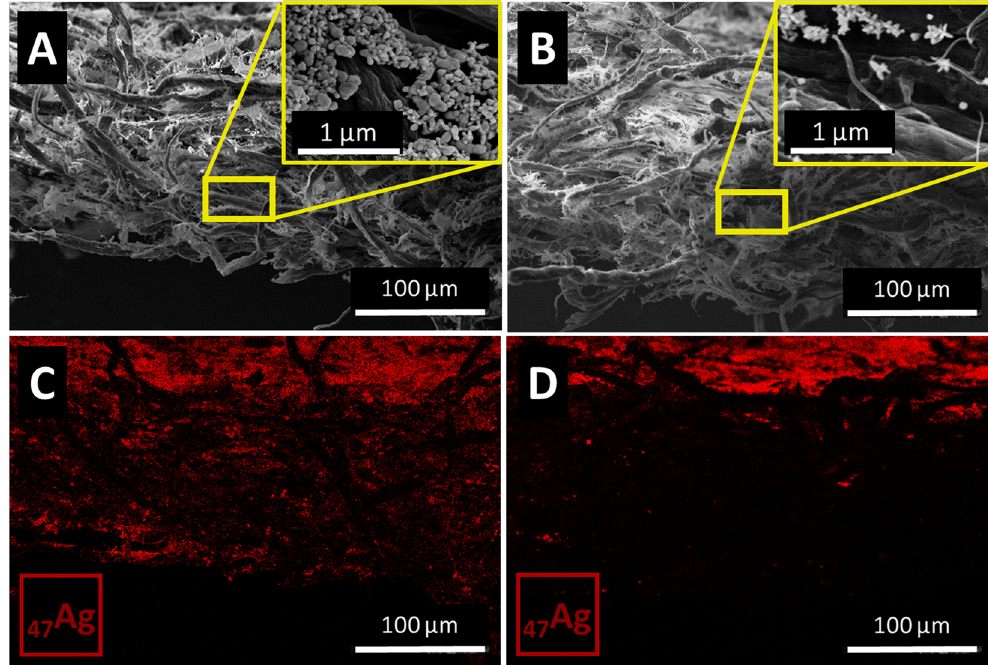
Figure 4. SEM micrographs and the respective EDS analysis images for elemental Ag, on the cross section of the paper plasmonic substrates with AgNSs on Whatman no. 1 paper ( A , C ), and on office paper ( B , D ). Silver can be detected across the bulk of the Whatman no. 1 paper although more concentrated at the surface; whereas for office paper, Ag is observed mostly at the substrate surface. Insets in ( A and B ) are magnified images of the bulk of the papers.